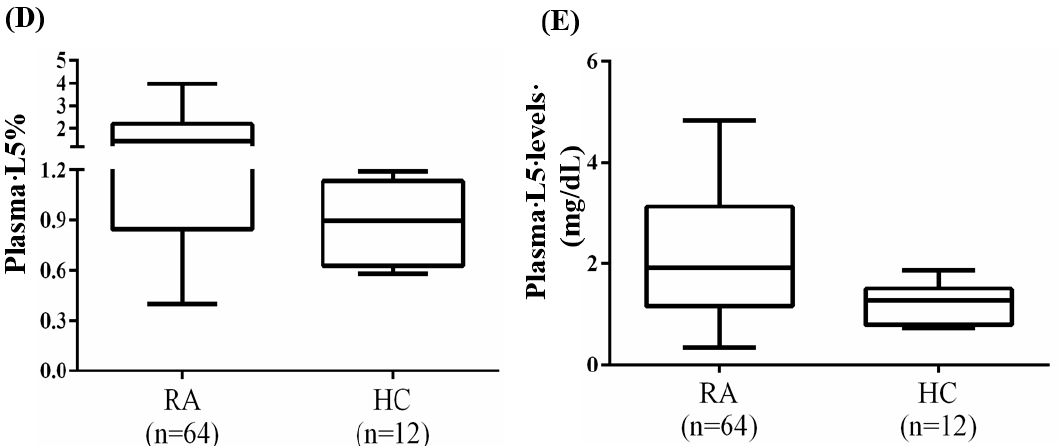
Figure 1. Analysis of LDL subfractions L1 and L5 from RA patients and HC individuals. LDL subfractions L1 and L5 were eluted at the indicated time points according to electronegativity by using anion-exchange fast-protein liquid chromatography. Chromatograms are shown for a ( A ) RA patient and ( B ) healthy control individual. ( C ) LDL subfractions were subjected to agarose gel electrophoresis at 100 V for 2 h (BSA was used as a reference). Comparisons of plasma L5% ( D ) and L5 levels ( E ) between RA patients and healthy controls are shown. The data are presented as box-plot diagrams, in which the box encompasses the 25th percentile (lower bar) to the 75th percentile (upper bar). The horizontal line within the box indicates the median value for each group. BSA: Bovine serum albumin; HC: Healthy control; LDL: Low-density lipoprotein; RA: Rheumatoid arthritis. HC: Healthy control; RA: Rheumatoid arthritis. * p < 0.05 and ** p < 0.005 vs. HC, determined by using the nonparametric Mann-Whitney U test.